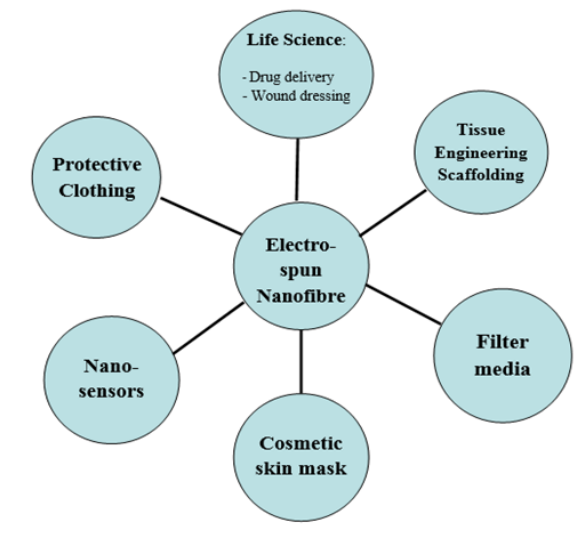
Figure 5: Potential applications of electrospun polymer nanofibers.